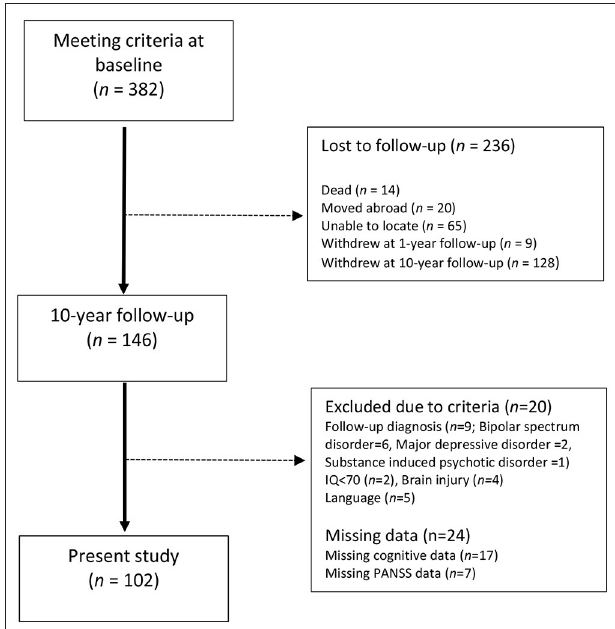
FIGURE 1 | Account of attrition in the 10-year